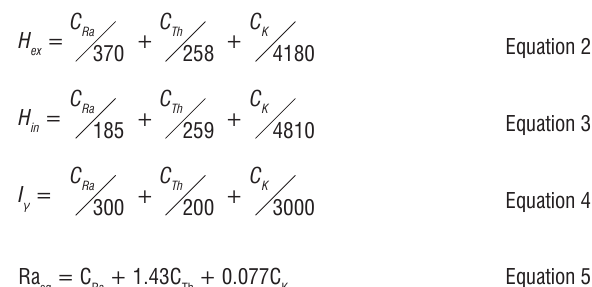
Radiation indices